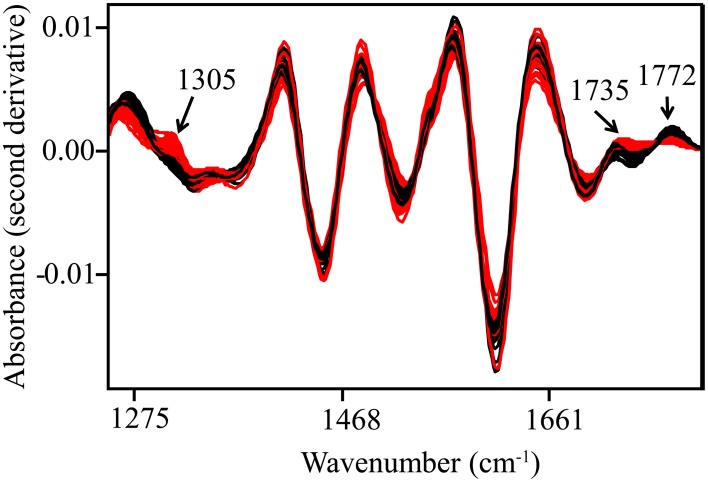
Second derivative and SNV-transformed spectra. Spectral bands with high discriminating power are indicated with arrows. Black—resistant trees; Red—susceptible trees.